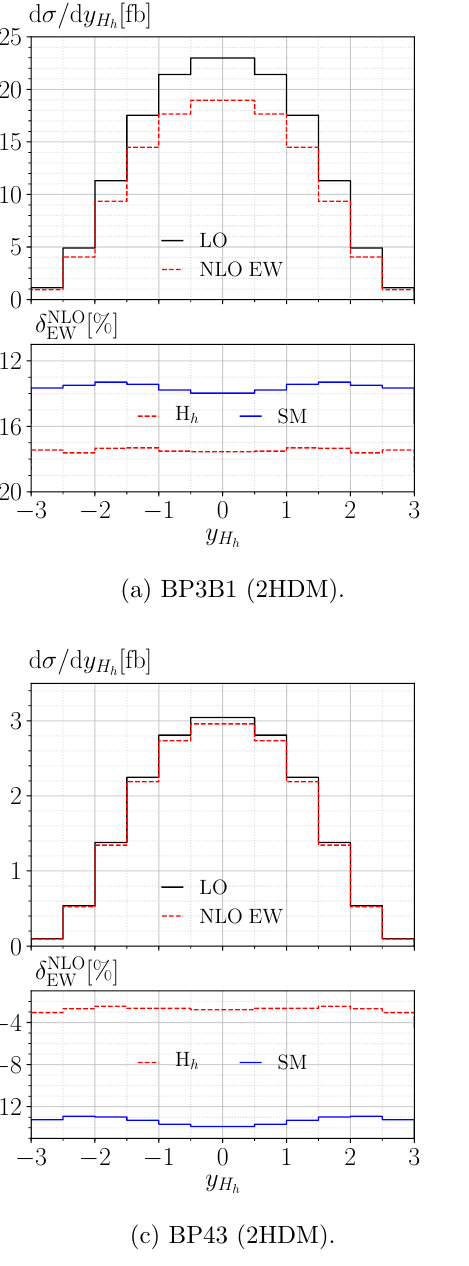
Figure 5. Distributions in the rapidity of the Higgs boson y strahlung for the benchmark points BP3B1 in (a), BP45 in (b) and BP43 in (c) in the 2HDM, and BP3 in (d) in the